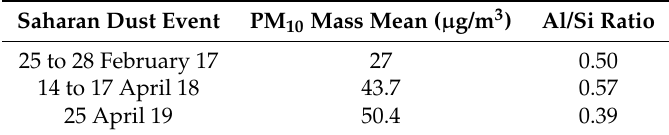
Table 11. Events and PM mass concentration considering AL/Si